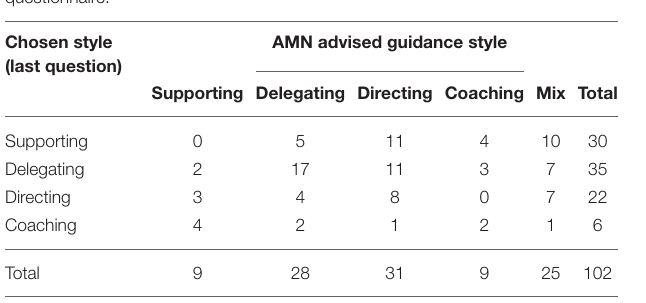
TABLE 6 | Cross tabulation of the guidance style advised by the AMN, and the style chosen by students as best fitting their needs in the last question of the questionnaire.